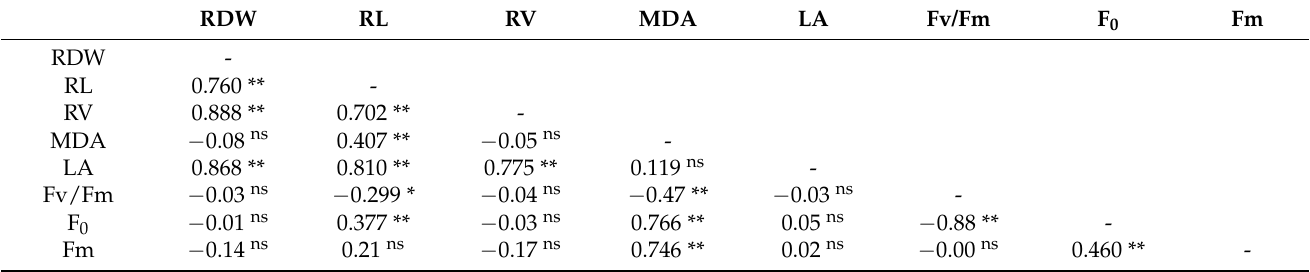
Table 2. Correlation coefficients among measured traits in four Echinacea cultivars treated by